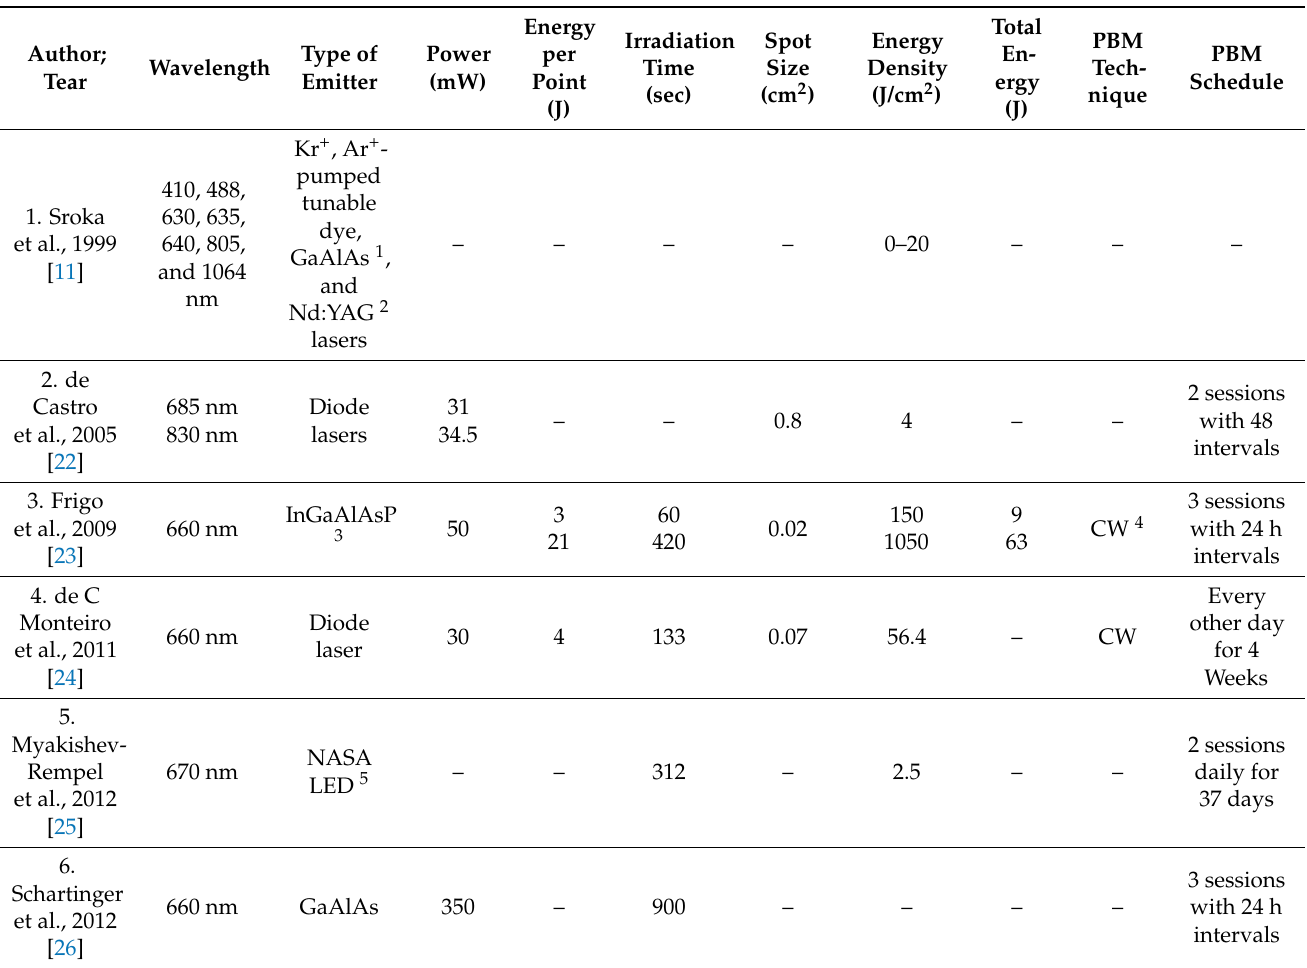
Table 3. Parameters of Photo-biomodulation (PBM) of all the included studies in this